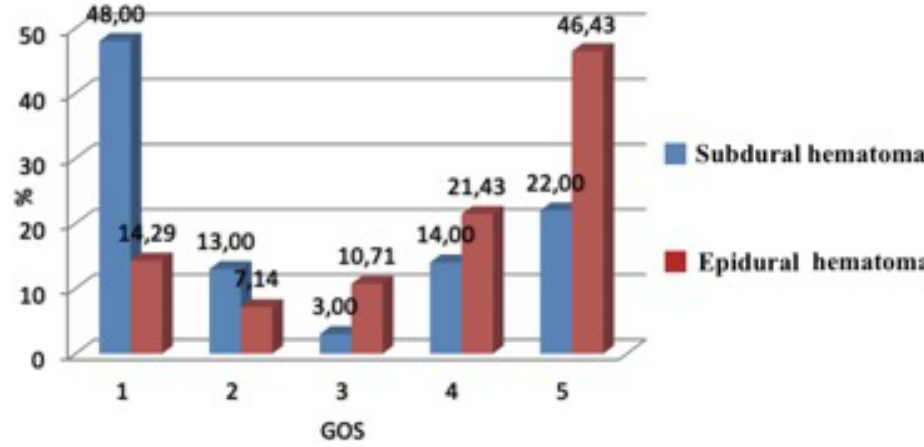
Figure 3. The percentage of patients in the groups according to their GOS score.